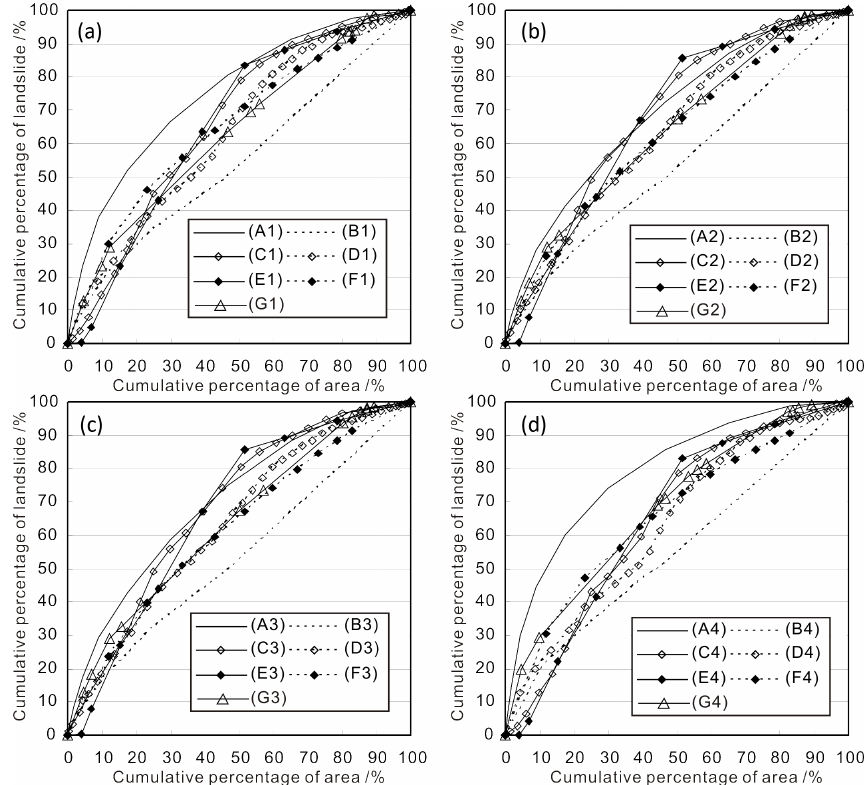
Figure 27. Cumulative landslide area curves to analyze the influence of the seven impact parameters on the landslide occurrences, separately shown by different landslide proxies. 1: landslide area, 2: landslide centroid point number, 3: landslide top point number, and 4: land- slide accumulation material volume. The curves are: A: slope angle, B: slope curvature, C: distance from epicenter, D: distance from the Enriquillo–Plantain Garden fault, E: PGA, and F: distance from